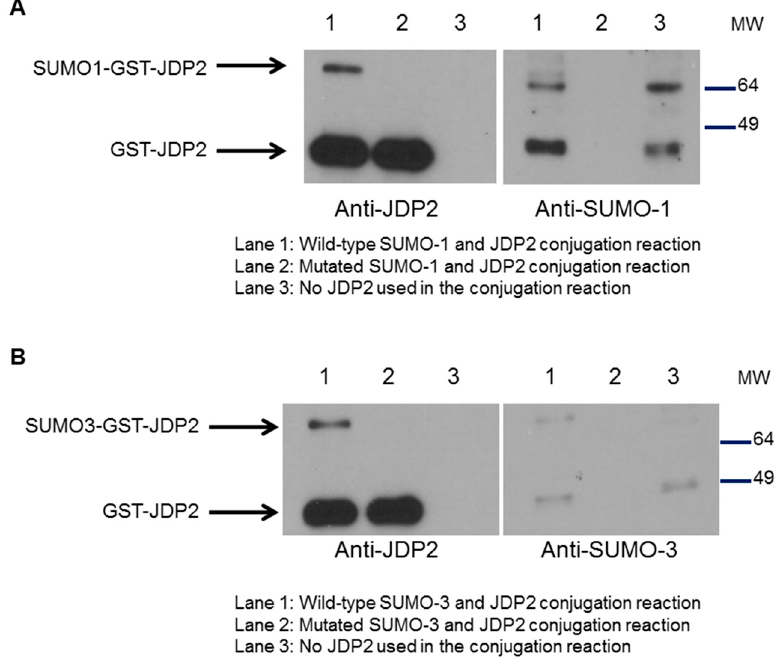
Figure 6. JDP2 is a novel substrate for SUMOylation. ( A ) In vitro SUMOylation of JDP2 with SUMO-1 wild-type and mutated form. GST-JDP2 protein was incubated with E1 and E2 enzymes and either wild-type or mutated SUMO-1 at 30 ◦ C for 3 h. Western blot analysis was performed by immunoblotting with JDP2 antibody ( left ) or SUMO-1 antibody ( right ); ( B ) In vitro SUMOylation of JDP2 with SUMO-3 wild-type and mutated form. GST-JDP2 protein was incubated with E1 and E2 enzymes and either wild-type or mutated SUMO-3 at 30 ◦ C for 3 h. Western blot analysis was performed by immunoblotting with JDP2 antibody ( left ) or SUMO-3 antibody ( right ). Experiments were performed three times with similar results. SUMO, small ubiquitin-like modifier. MW: molecular